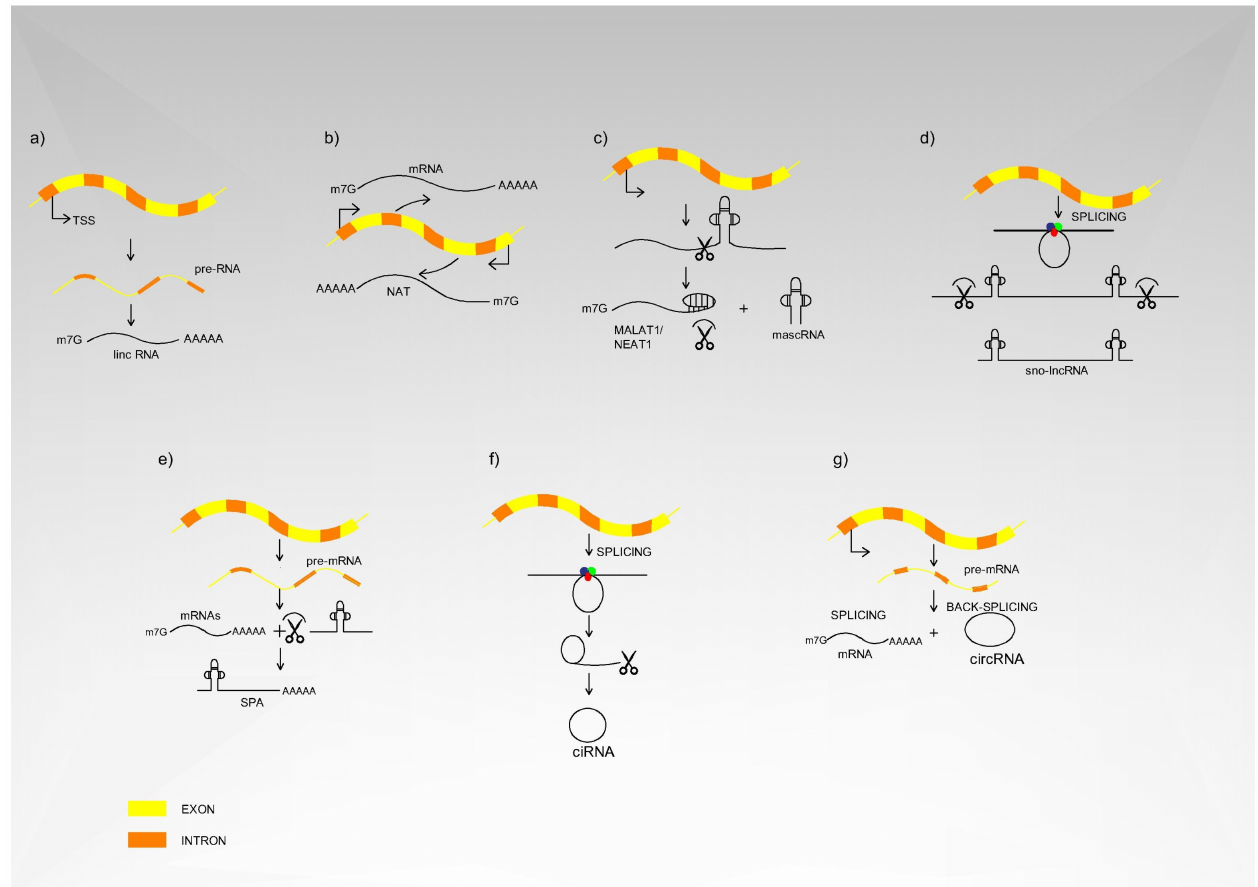
Figure 2. Variability in Long-noncoding RNA biogenesis. ( a ) Long intergenic non-coding RNAs (lincRNAs) are transcribed by Polymerase II from regions between two protein coding genes, and they are usually capped, polyadenylated and spliced as in mRNA, but some undergo only terminal cleavage and premature termination. ( b ) Natural antisense transcripts (NAT) are synthesised by RNA polymerase II from the antisense strand of the protein coding gene. There are three NAT forms – Complete, Intron-overlapped and Exon-overlaped. ( c ) MALAT1/NEAT1 is cleaved by RNAseP after transcription. The U-A-U structure stabilises its 3 (cid:48) end and inhibits further cleavage and mascRNA 3 (cid:48) -end products with unknown function are also created. ( d ) sno lncRNAs are products of intron excision. The snoRNP complex is formed on both ends, and this protects sequence from further degradation. sno lncRNAs lack both capping and polyadenylation. ( e ) SPA lncRNAs have snoRNP at their 5 (cid:48) ends and 3 (cid:48) -ends and are polyadenylated. They originate as a product of read-through transcription, and this is followed by multistep 5 (cid:48) end trimming and 3 (cid:48) end processing. ( f ) Circular intronic RNAs are products of excision of intron with consensus sequence (5 (cid:48) splice site is GU rich and branchpoint site is C rich), 3 (cid:48) end is usually trimmed and debranched. ( g ) Finally, the circular RNAs (circRNAs) are products of circular back-slicing of the pre-mRNA exons. Edited from [26] with